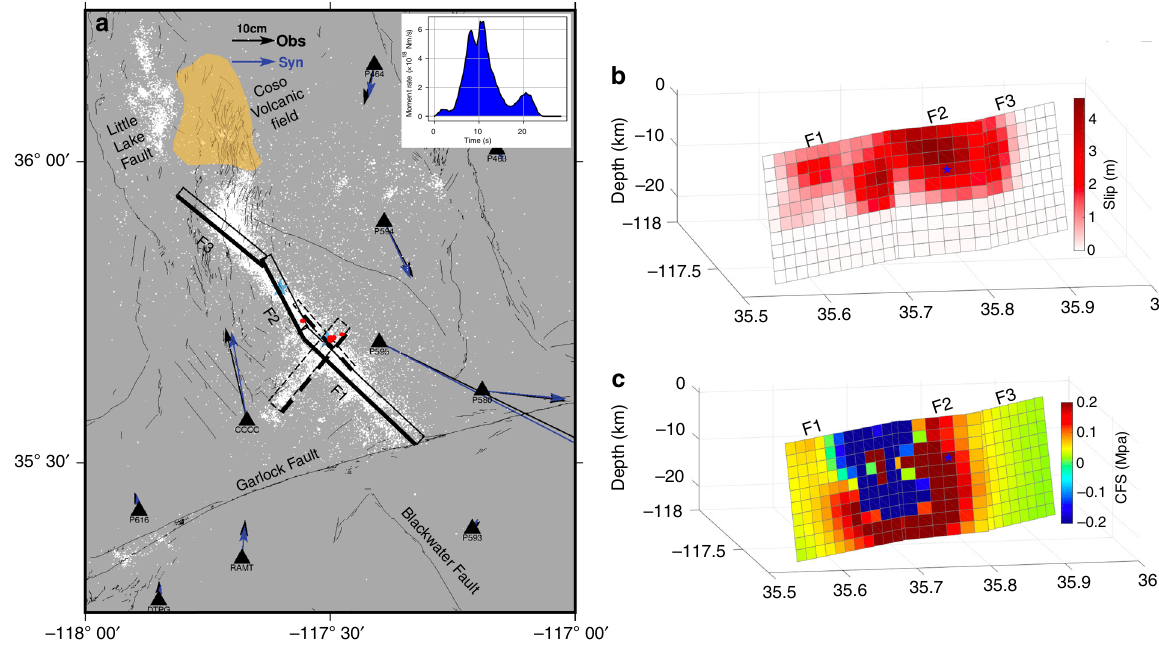
Fig. 3 Source model of the M w 7.1 earthquake of July 6, 2019. a Co-seismic GPS measurements (black arrow) and synthetics (blue arrow). White dots show seismicity after the M w 6.5 event until 1 August, 2019, red dots are foreshocks. The catalogue is from the Southern California Seismic Network which is available on-line (https://scedc.caltech.edu/eq-catalogs/index.html). Solid and dashed rectangle outlines projections of the faults adopted in this study for the M w 7.1 and M w 6.5 events, respectively, and the thick edges are at the surface. Left top corner, moment rate function derived. b Model of the slip distribution for fault F1, F2 and F3, the blue star shows the hypocenter location. c Coulomb Stress Failure on the fault of the M w 7.1 event induced by the M w 6.5 earthquake, note that the color bar is